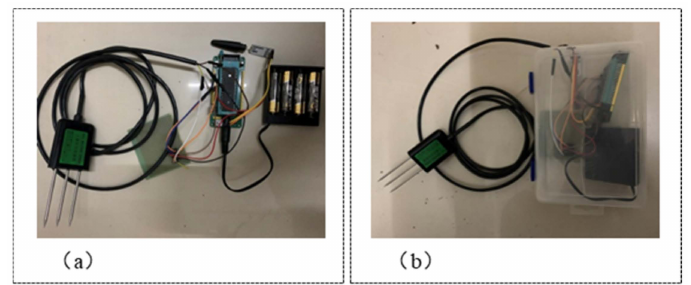
Figure 2. WUSN nodes ( a ) before node encapsulation, and ( b ) after node